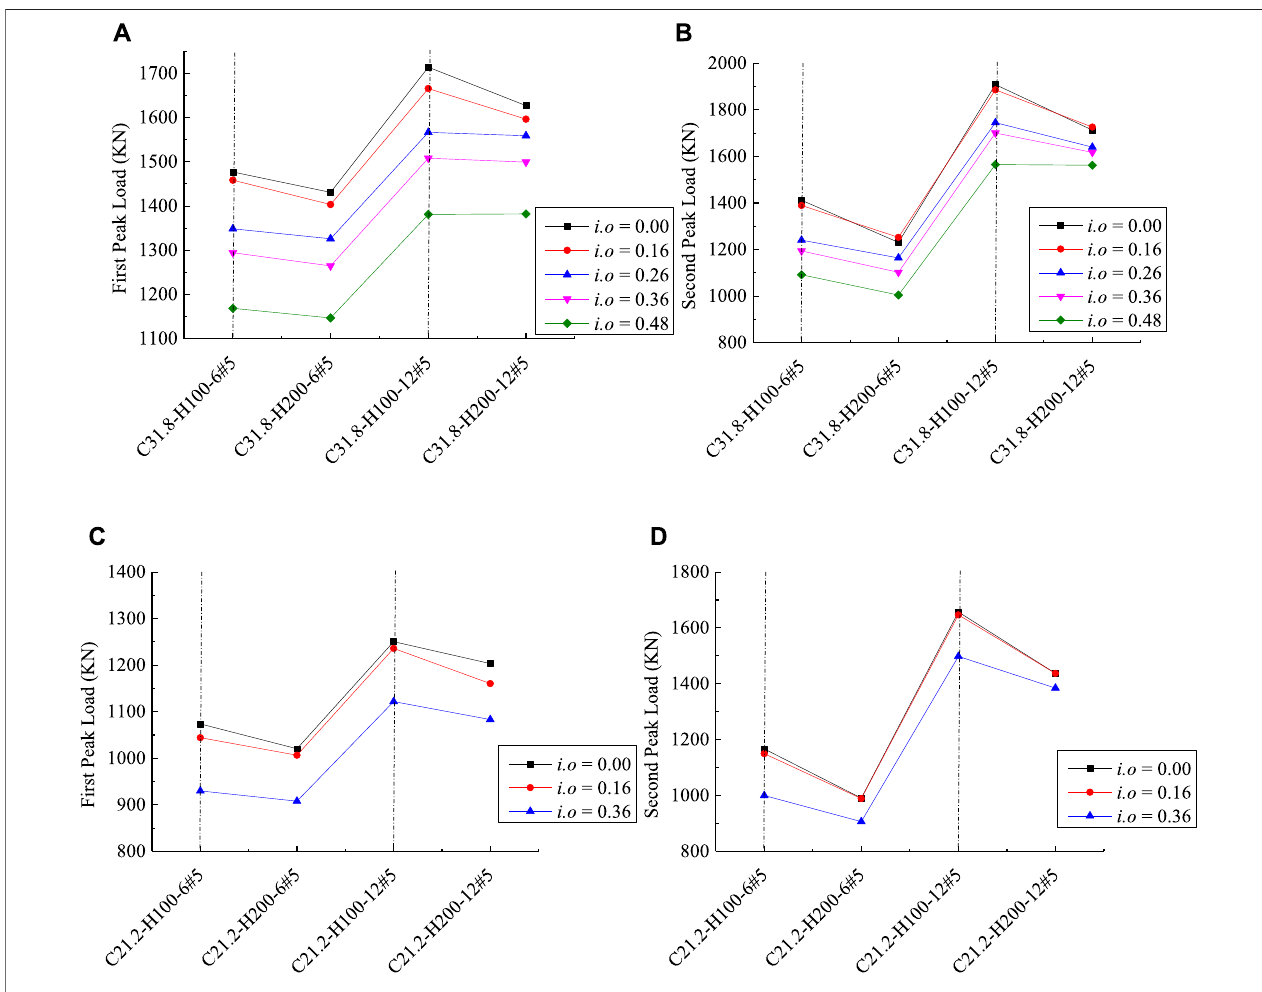
FIGURE 9 | Effect of the amount of con fi nement and longitudinal reinforcement on the load-carrying capacities for columns with different compressive concrete strengths. (A, B) GFRP-RC HCCs with concrete strength of 31.8 MPa; (C, D) GFRP-RC HCCs with concrete strength of 21.2 MPa.